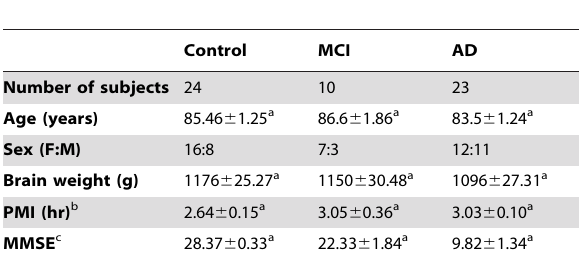
Table 1. Demographic and psychiatric profile of AD patients and